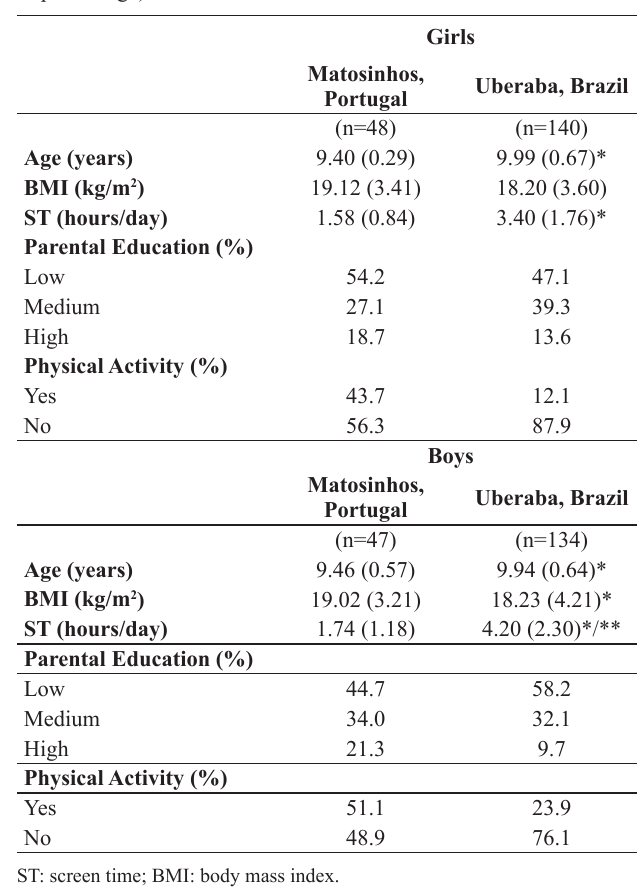
Table 1. Descriptive characteristics (mean (standard deviation) or